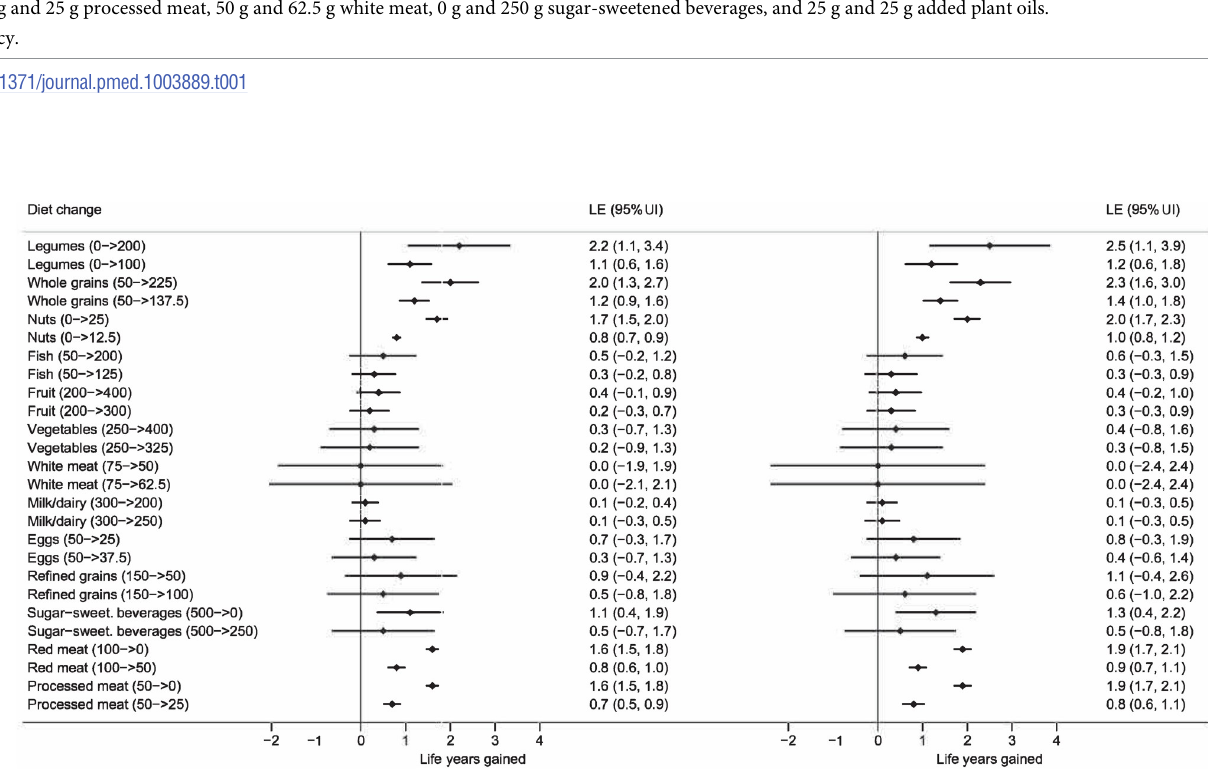
PLOS Medicine| https://doi.org/10.1371/journal.pmed.1003889 February 8,